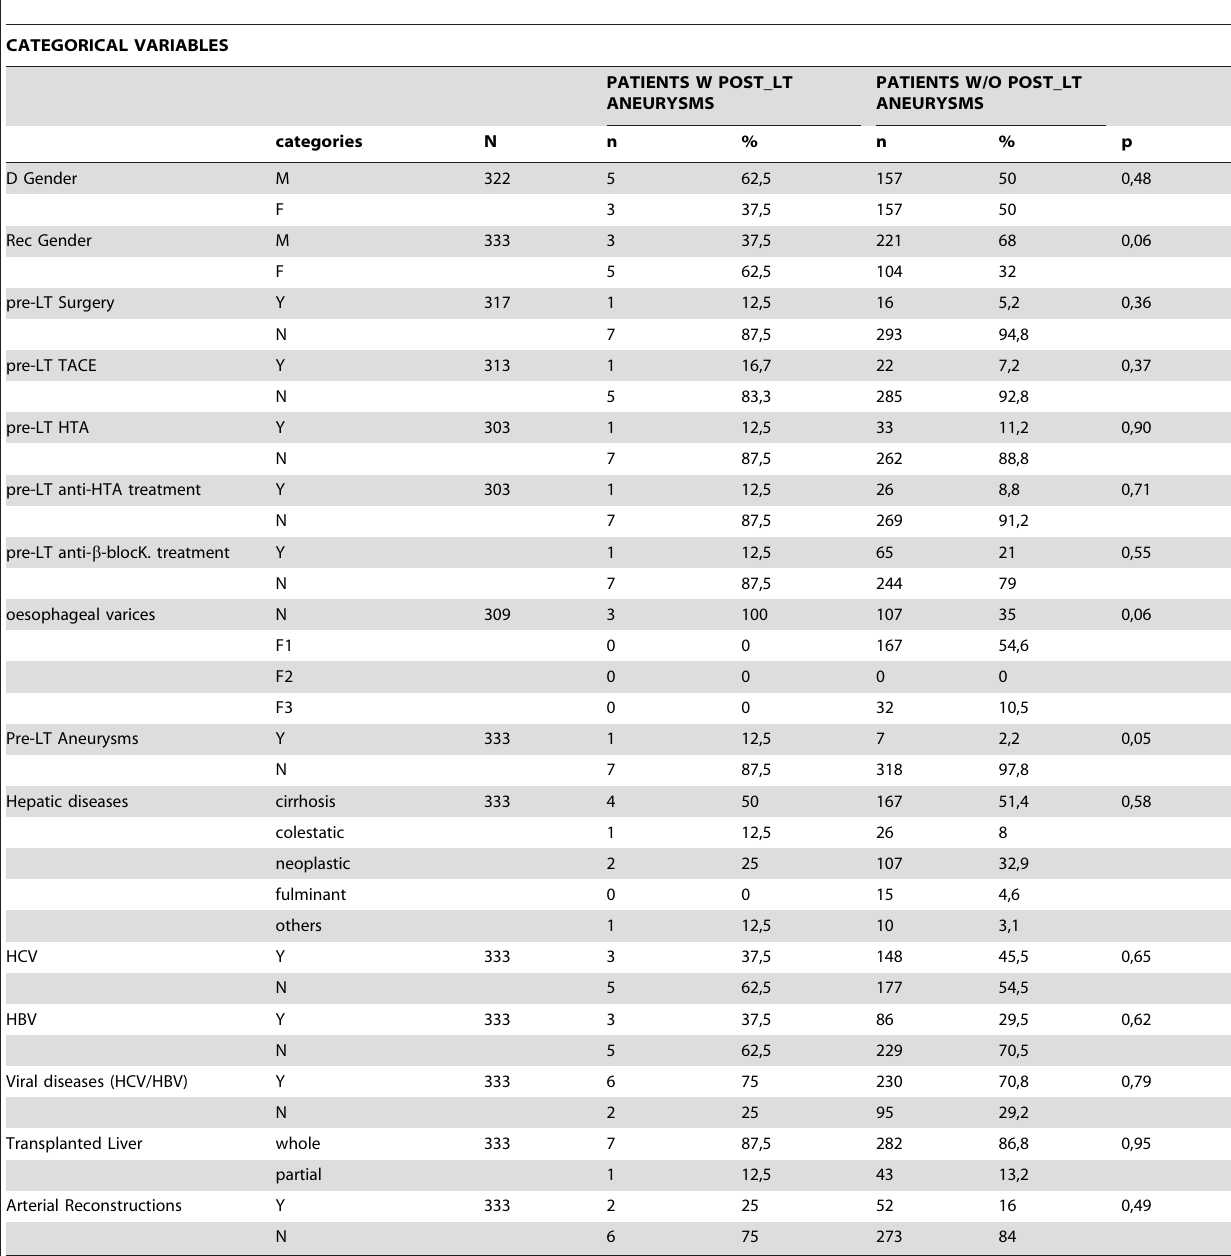
Table 5. Univariate analysis of categorical variables (just before LT) of transplanted patients, according to the presence of post-LT visceral